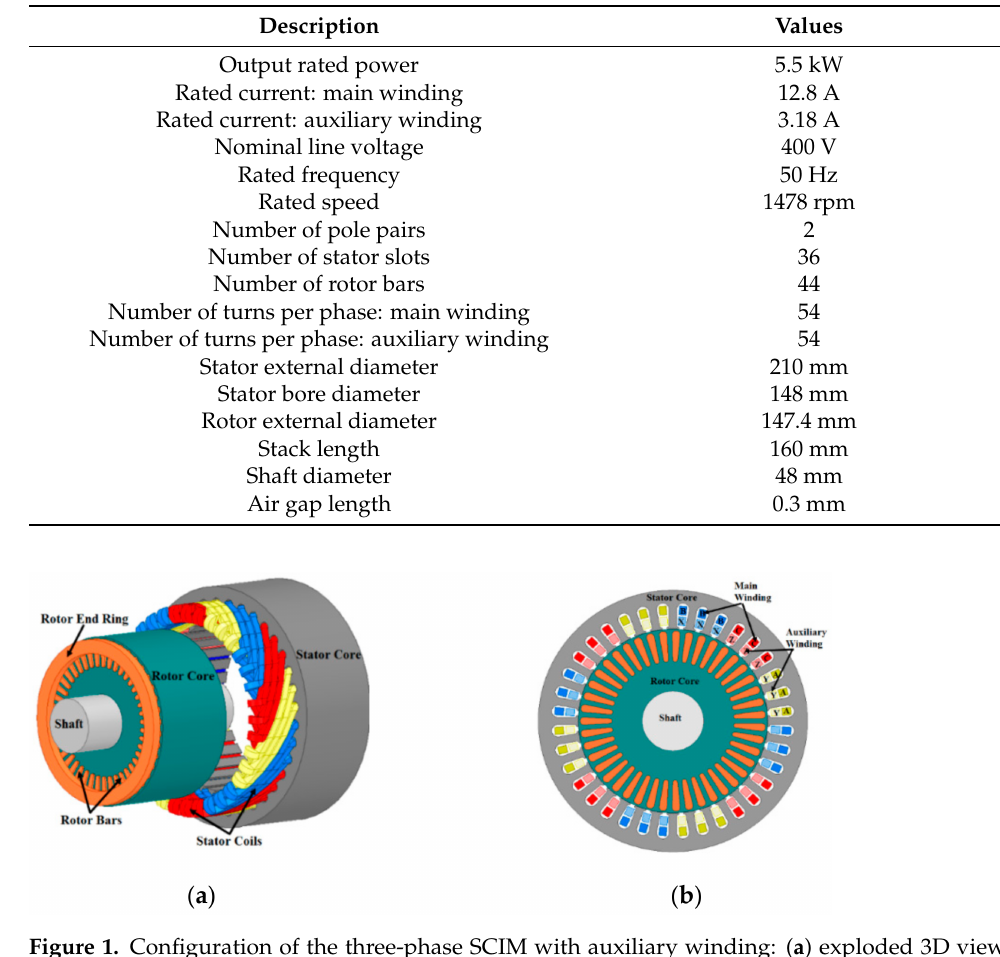
Table 1. Specifications and ratings of the unoptimized motor.